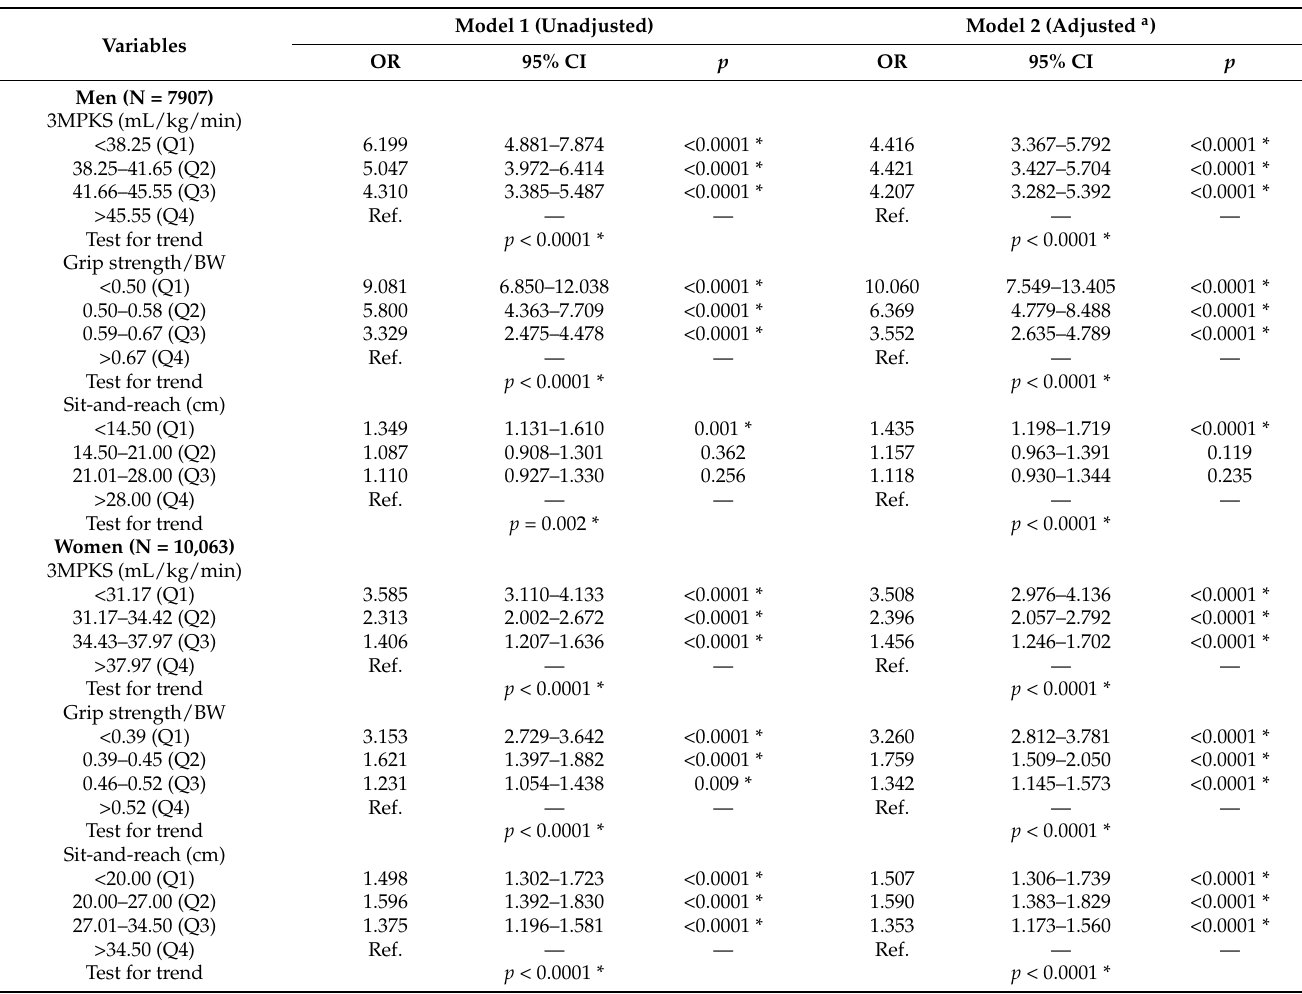
Table 5. Multivariate adjusted ORs for abdominal obesity in relation to the quartiles of the physical fitness measurements after adjustment for potential